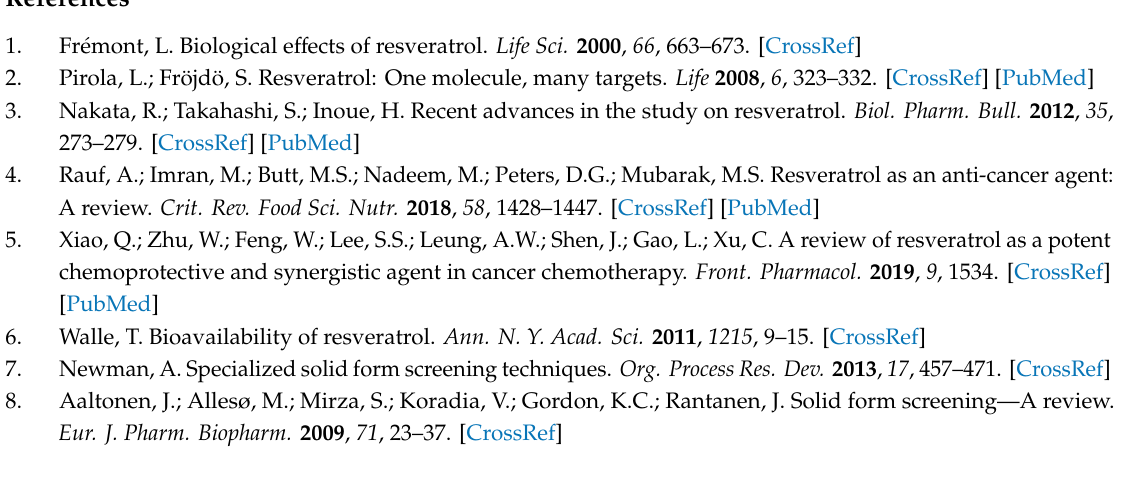
Table S1: Solvents and volumes used in the recrystallizations of commercial RSV with thermal data by DSC of samples isolated, (Standard deviation in parentheses ( n = 3)), Table S2: Peak assignments and integrations for host-guest stoichiometry, Figure S1: 1 H NMR spectrum for γ -CD · RSV stoichiometry determination, Figure S2: Inclusion of an ordered guest (12-crown-4) within the channel formed by γ -CD host molecules (CSD refcode DOCYID). Figure S3: The simulated and experimental PXRD patterns of the γ -CD · RSV hydrate complex. CCDC 1974533 contains the supplementary crystallographic data for the crystal structure refinement based on the SQUEEZE routine). These data can be obtained free of charge via http: // www.ccdc.cam.ac.uk / conts / retrieving.html (or from the CCDC, 12 Union Road, Cambridge CB2 1EZ, UK; Fax: + 44-1223-336-033; E-mail: